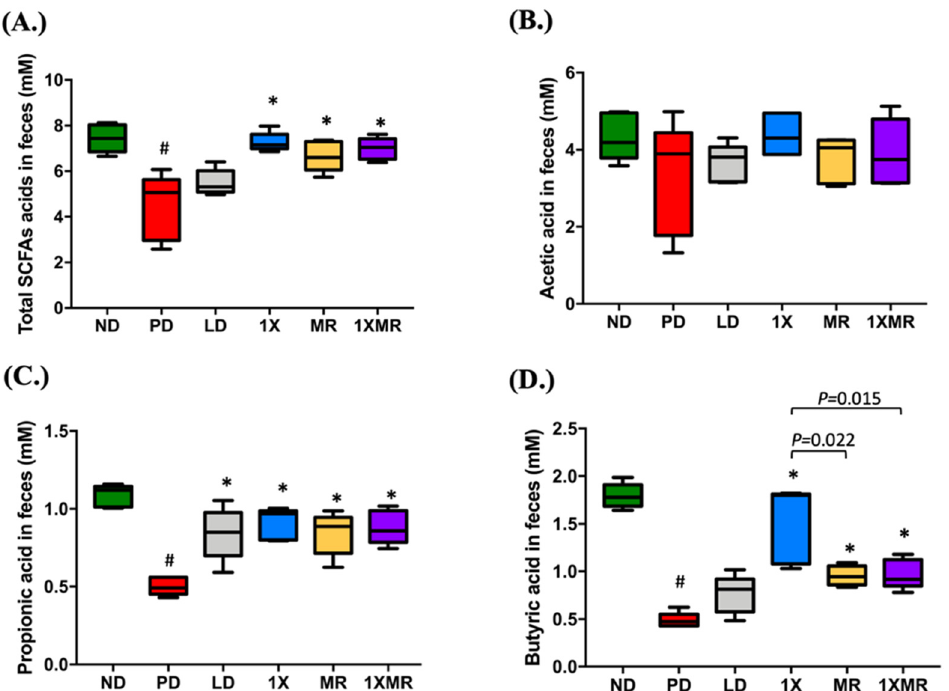
Figure 3. Effects of 8 weeks of supplementation with 1X, MR, and 1XMR on the fecal concentrations of ( A ) short-chain fatty acids, ( B ) acetic acid, ( C ) propionic acid, and ( D ) butyric acid. Values are reported as mean ± SEM for 5 rats per group. Significant differences (bars) are expressed as p < 0.05. One-way ANOVA with Tukey’s post hoc test; # p < 0.05 for comparison of the PD group with the ND group; * p < 0.05 for comparison of LD, 1X, MR, and 1XMR groups with the PD group. ND, non-diseased; PD, untreated PD; LD, PD treated with 8 mg of L-DOPA; 1X, PD supplemented with the probiotic; MR, PD supplemented with MR as prebiotic; 1XMR, PD supplemented with a combination of 1X and MR.